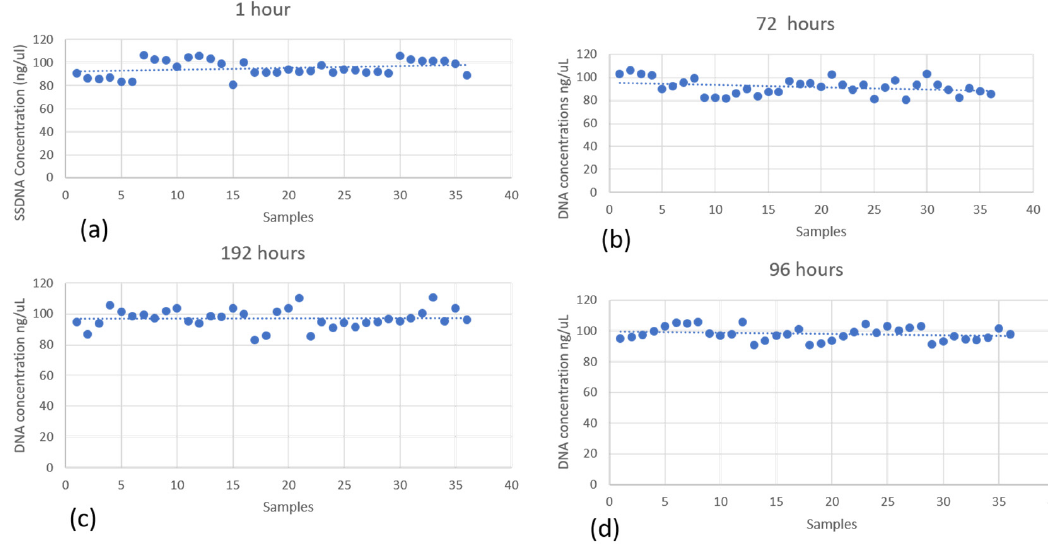
Figure 3. DNA retrieval from the surface of Teflon after ( a ) 1 h, ( b ) 72 h, ( c ) 96 h, and ( d ) 193 h.